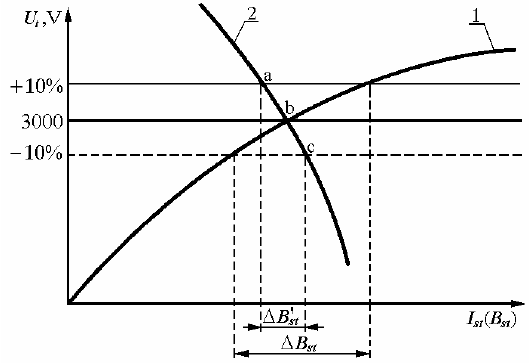
Fig 3. Regenerative braking control by using a special excitation generator (with the characteristic